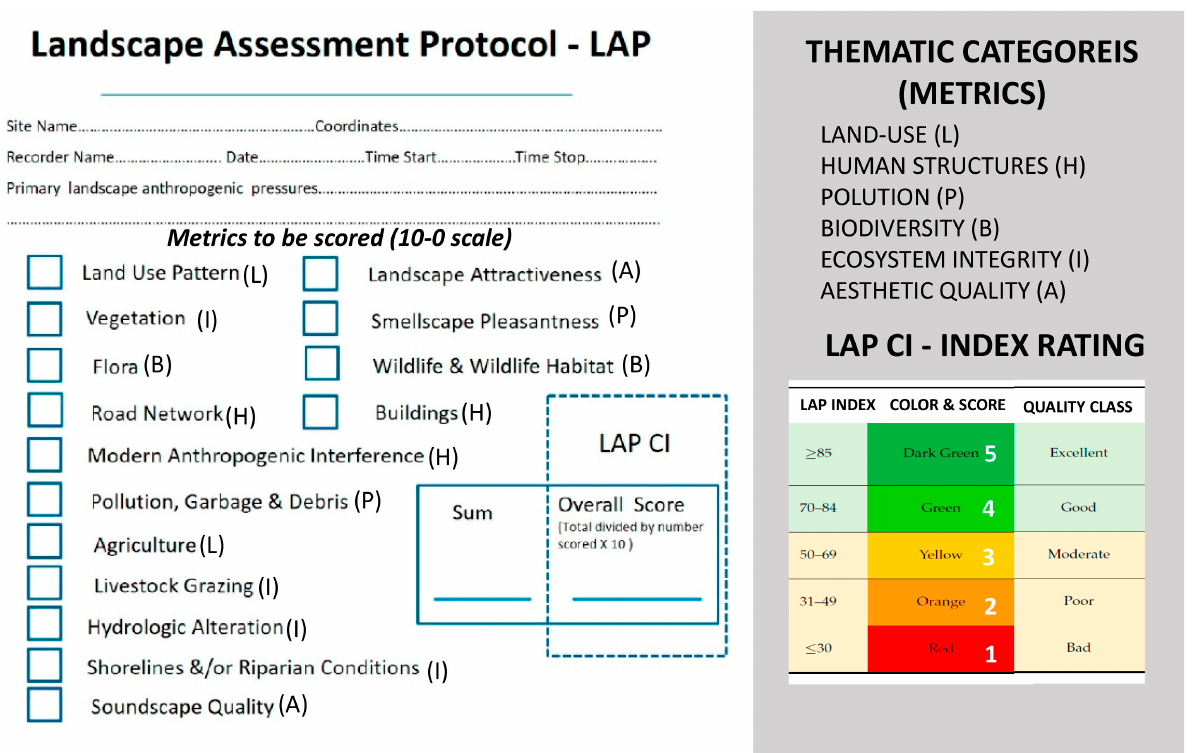
Figure 1. The LAP field form’s scoring card with the 15 metrics—the first page of the field protocol, where they are scored on a 10–0 scale ( Left ). In the grey inset ( Right ): a summary interpretation reiterates that there are six thematic categories to each metric (shown in parentheses beside each metric). Inset at Right: the original rating scale class boundaries and quality class characterizations of the LAP conservation index (LAP CI), following Vlami and colleagues 2019 [58]).